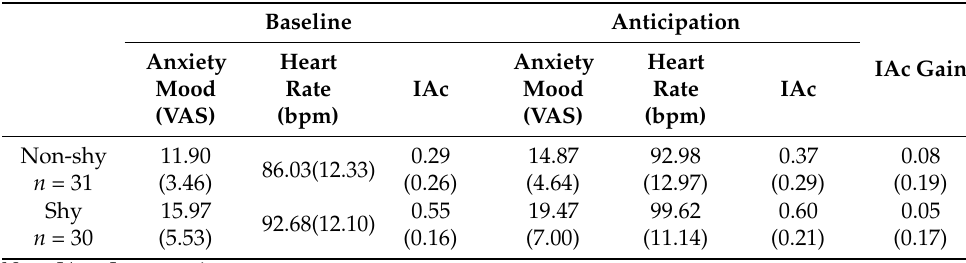
Table 2. Means and standard deviations of self-reported anxiety, heart rate, and interoceptive accuracies (IAc) for shy and non-shy adolescents in baseline and speech anticipation conditions. Baseline